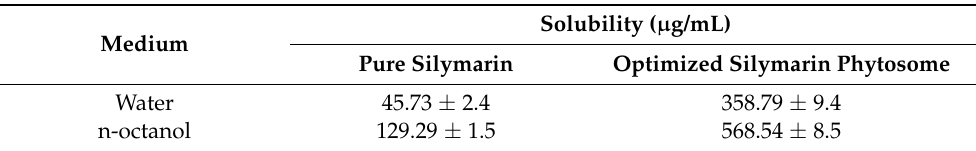
Table 2. Solubility of pure silymarin and optimized silymarin phytosomal formulation in water and phosphate buffer pH